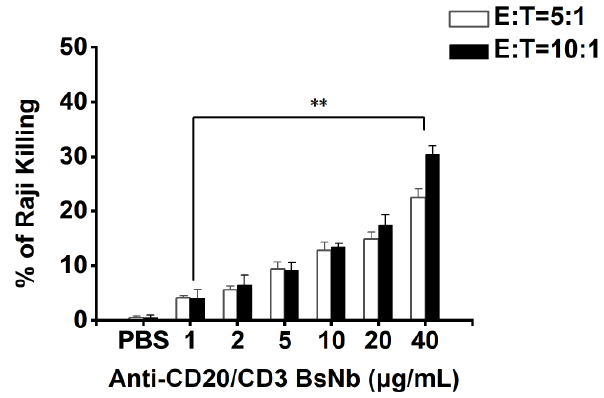
Figure 8. The LDH assay was used to determine the anti-CD20/CD3 BsNb-mediated killing activity of PBMCs against tumor cells. Raji cells were cultured in a PerkinElmer Cell Carrier for 12 h. PBMCs were added to each group in three parallel wells at ratios of effector: target = 5:1 and effector: target = 10:1, and anti-CD20/CD3 BsNb was added to the experimental group to a final concentration of 40 μg/mL, 20 μg/mL, 10 μg/mL, 5 μg/mL, 2 μg/mL, and 1 μg/mL. Then, 100 μL RPMI 1640 medium was added to blank wells, 50 μL of Raji cells + 50 μL of PBMCs were added to sample control wells, and 50 μL of Raji cells + 50 μL of PBMCs + 10 μL of lysate were ad ded to maximum enzyme activity control wells and incubated for 24 h at 37 °C. Then, 10 μL of lysate was added to the target cell maximum release wells 1 h before the end of incubation and mixed thor- oughly. The optical density was measured at OD490 nm with a microplate reader, and the mortal- ity rate of Raji cells was calculated using the following common formula: mortality rate (%) = {[(sample well OD490 nm-blank well OD490 nm) − (sample control well OD490 nm-blank well OD490 nm)]/(maximum enzyme activity control well OD490 nm-blank well OD490 nm)} × 100% (** p < 0.01) . 3.10. Detection of the Effect of Anti-CD20/CD3 BsNb on Cytokine Secretion by PBMCs An ELISA quantitative method was used to detect the cytokine secretion of PBMCs stimulated by anti-CD20/CD3 BsNb when the target cells were incubated with effector cells, and the cytokine secretion of PBMCs stimulated by anti-CD20 /CD3 BsNb when effector cells were present, as shown in Figure 9. The level of IFN- γ secreted by PBMCs and stimulated by anti-CD20 /CD3 BsNb was increased significantly ( p < 0.01) in a con- centration-dependent manner in the presence of target cells. These results indicated that the activation of T cells into killer effector cells induced by anti-CD20/CD3 BsNb was dose dependent in the presence of tumor cells. Meanwhile, we also observed a dose-dependent increase in IFN- γ secretion in the control group when the an- ti-CD20/CD3 BsNb was incubated alone with PBMCs, and the level of IFN- γ secretion was approximately 50 – 60% of the experimental group.